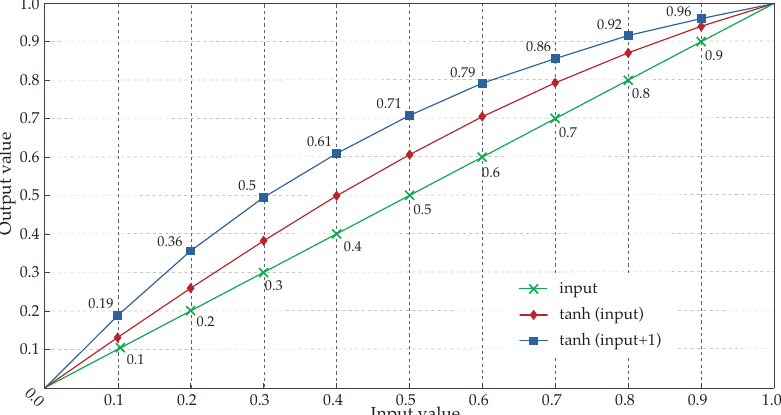
Figure 5. Hyperbolic tangent response to normalized input values. Diamonds correspond to the normalized output values after the application of the hyperbolic tangent to the input values (crosses). Squares refer to the response employed by the algorithm, ranging the value of the hyperbolic tangent’s argument from 1 to 2 by adding 1 to the input value. The corresponding result, once normalized, is a greater increase of the input